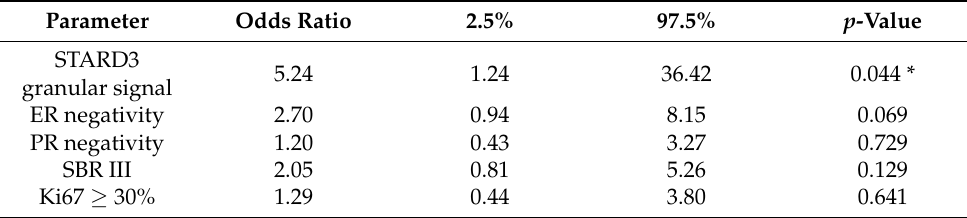
Table 5. Multivariate analysis of pathological parameters impact on